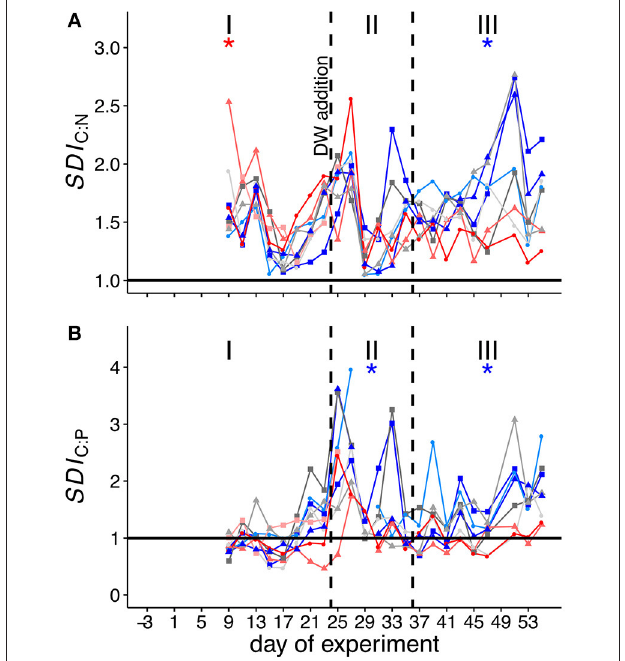
FIGURE 4 | SDI (stoichiometry-based degradation index), depicting the relation between the elemental stoichiometries of the water column and sedimented POM. SDI of C:N (A) and C:P (B) . The horizontal lines indicate a 1:1 relationship and thus equal stoichiometries in the sediment trap and water column POM. The dashed vertical lines indicate experimental phases for water column material. Colors and symbols are described in Table 1 . The * denotes a statistically significant postitive (red) or negative (blue) effect of CO 2 during the respective experimental phase.